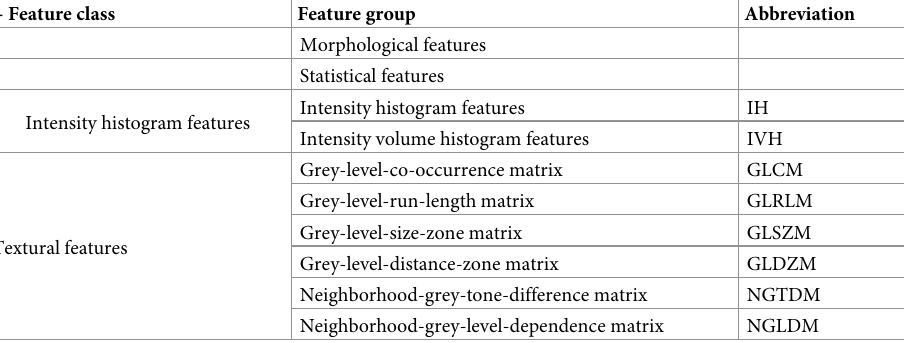
Table 2. Implemented feature groups and corresponding